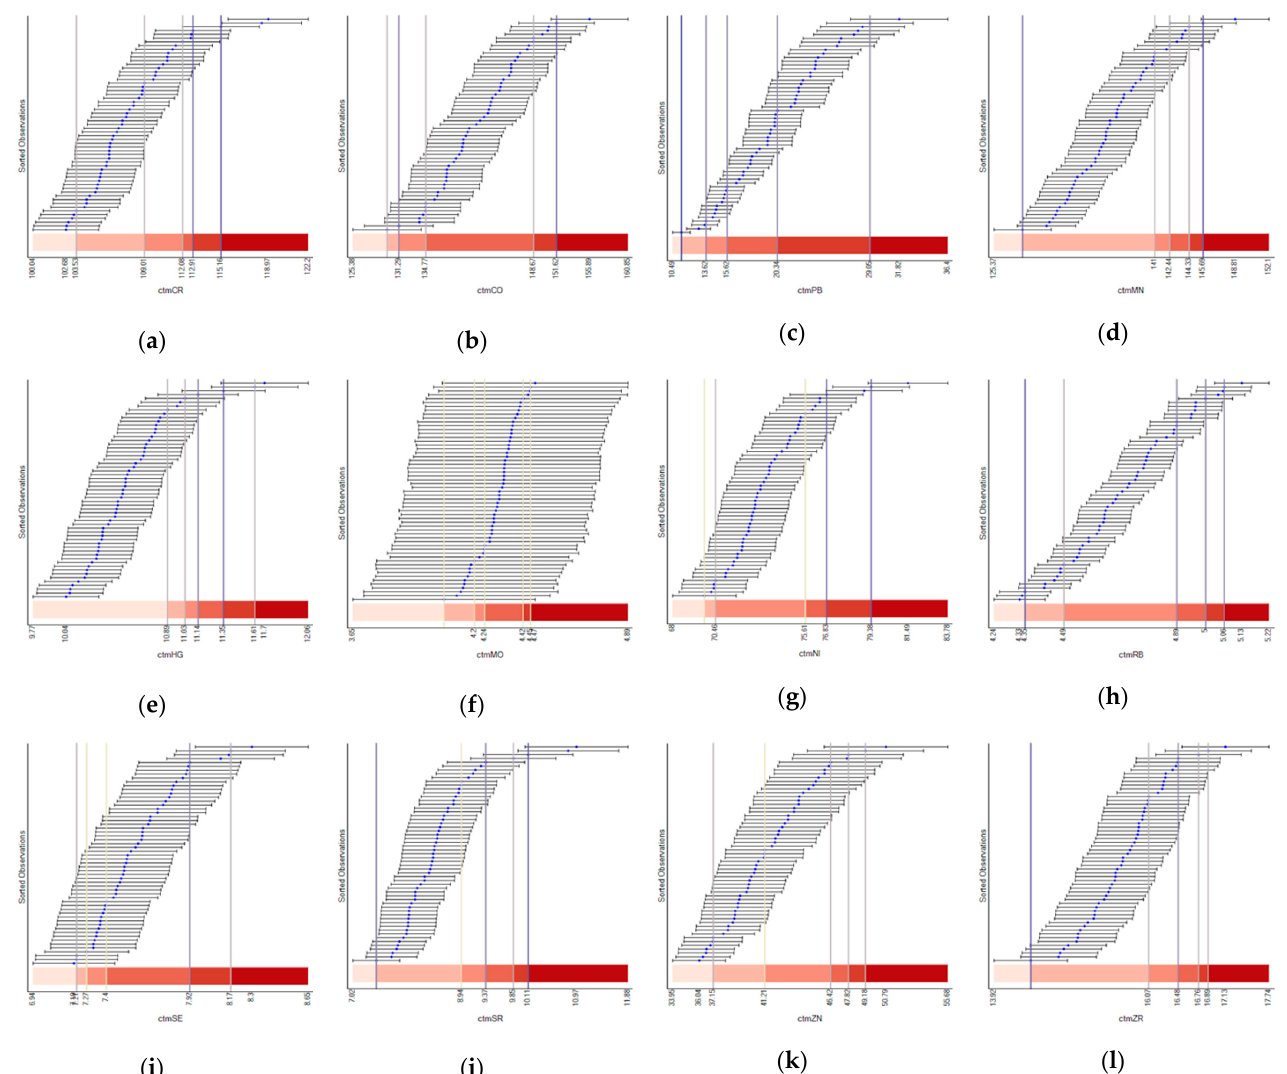
Figure A2. Classification results of assay errors and the corresponding theoretical analytical measurement error for three selected heavy metals: ( a ) Cr, ( b ) Co, ( c ) Pb, ( d ) Mn, ( e ) Hg, ( f ) Mo, ( g ) Ni, ( h ) Rb, ( i ) Se, ( j ) Sr, ( k ) Zn, and ( l ) Zr.